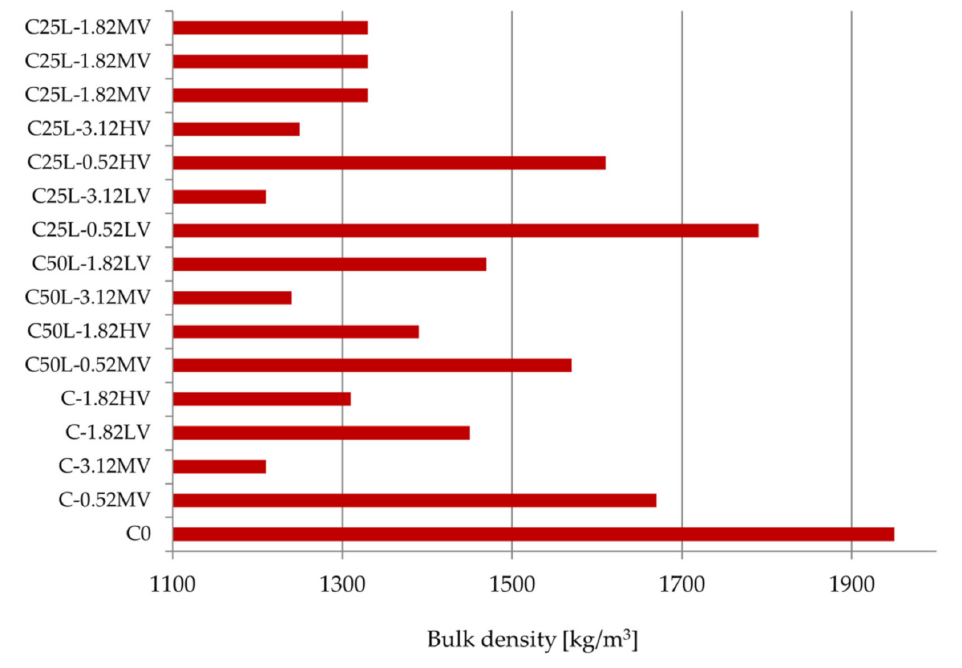
Figure 4. Results of bulk density of fresh mortars.